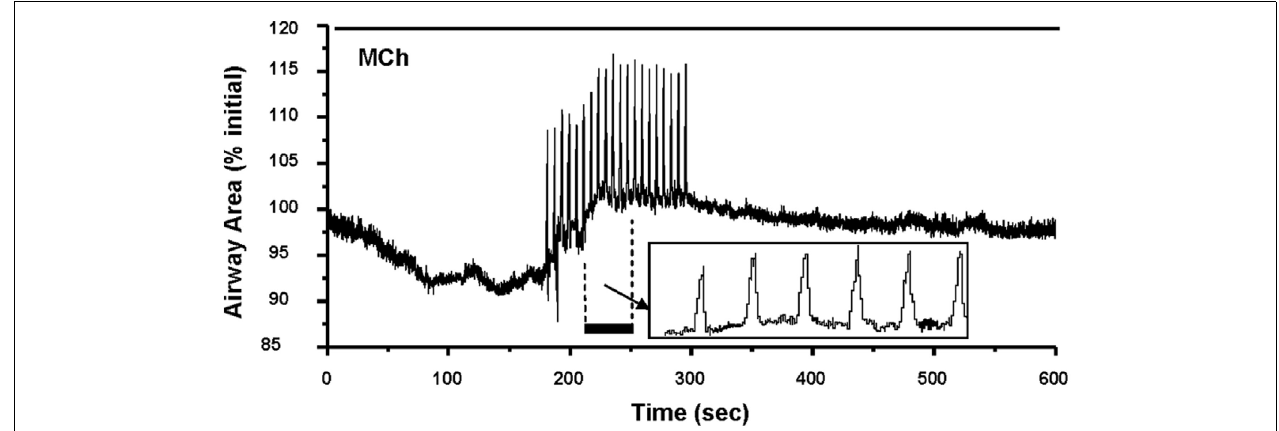
responded with an increase in the baseline of airway size (relaxed).When stretching was terminated, the airway began to slowly re-contract in response to the continual presence of